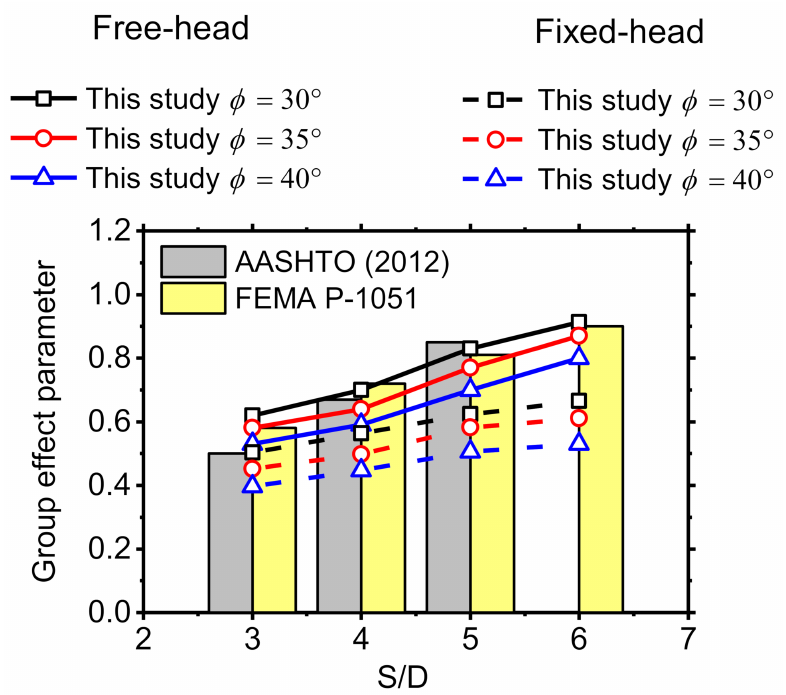
Figure 10. Comparison among calculated group effect parameters for 3 × 3 free-head and fixed-head pile groups in this study, AASHTO [33], and FEMA